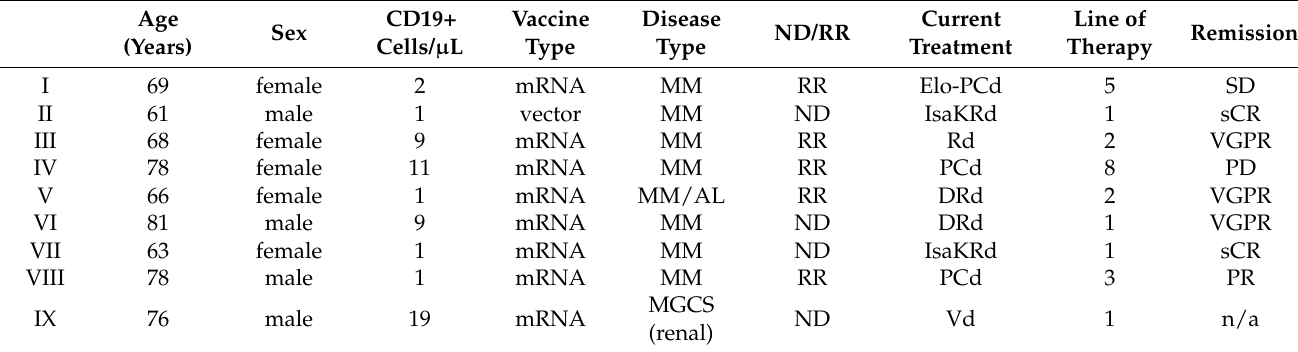
Table 3. Descriptive characterization of non-responders.